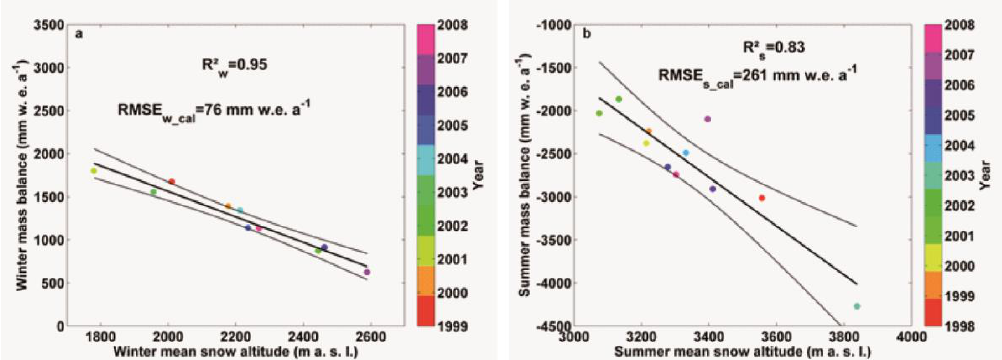
Figure 10. Observed ( a ) winter and ( b ) summer SMB of Griesgletscher, central Swiss Alps, as a function of the mean regional snow altitude Z for each year of the calibration period represented by coloured dots. Dashed thin lines represent the 95% confidence intervals for linear regression (solid line). From Drolon et al. [51].